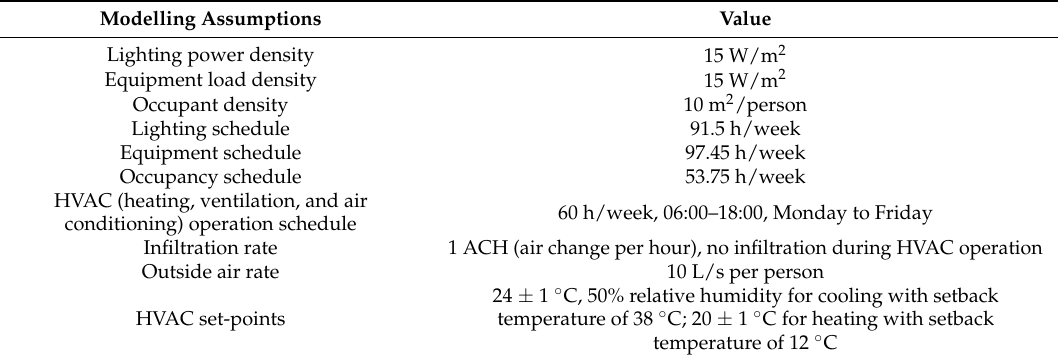
Table 2. Modelling assumptions of internal load density and operational schedules